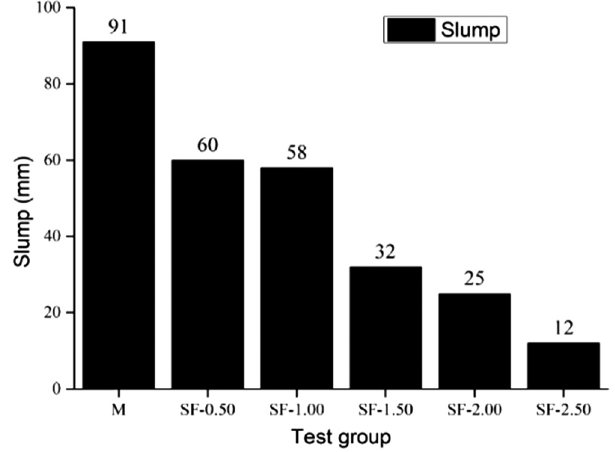
Figure 14: Slump test result.